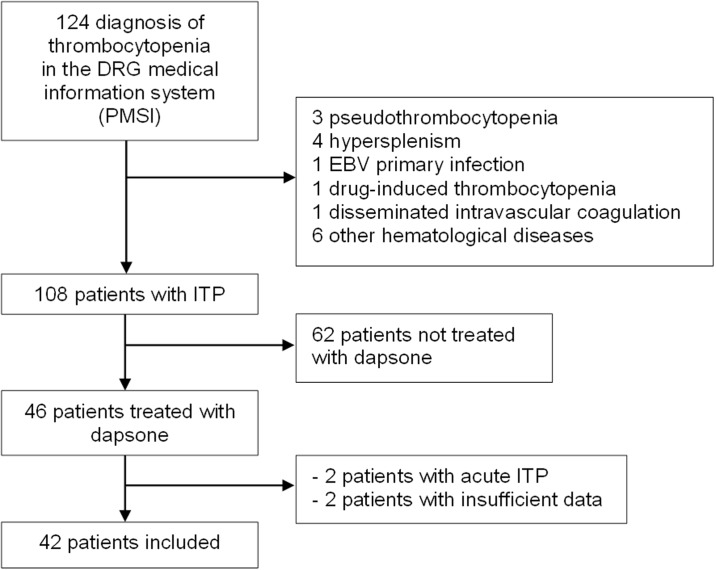
Flowchart of the study.